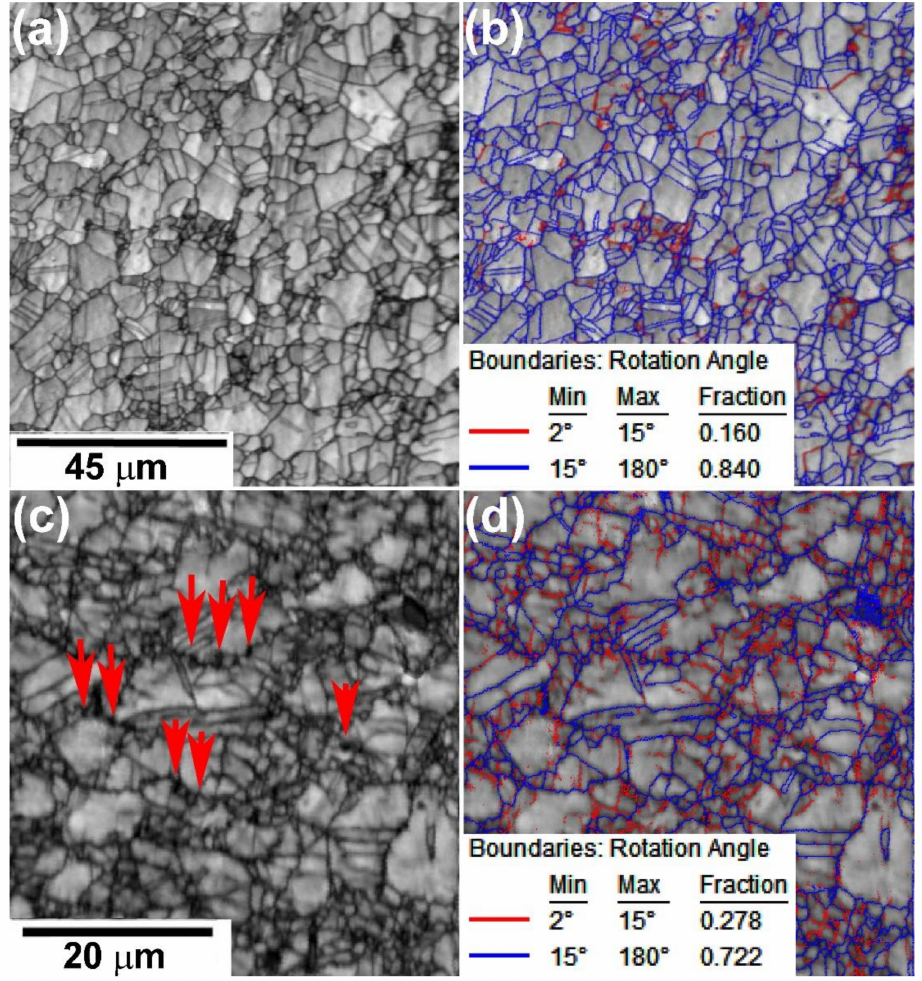
Figure 8. EBSD from samples with 13 passes quenched immediately after deformation, for interpass time of 5 s; ( a , b ) for the F138 steel, and ( c , d ) for the ISO steel. Red arrows indicate the position of second phase particles. IQ maps: ( a , c ). Maps of the distribution of boundaries superimposed to respective IQ images showing high-angle (misorientations θ > 15 ◦ , blue lines) and low-angle (subgrains, 2 ◦ < θ < 15 ◦ , red lines) grain boundaries: ( b , d